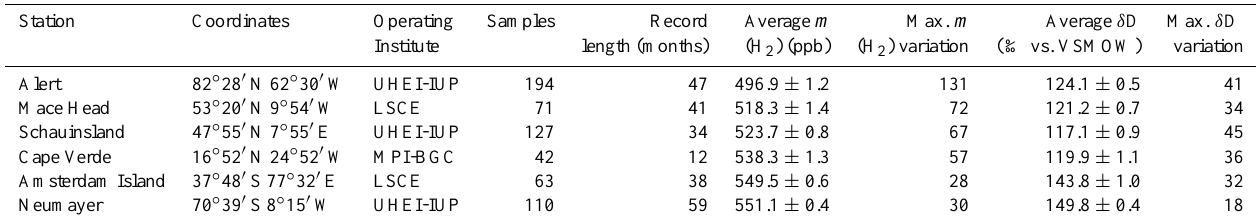
Table 2. The locations and operating institutes of the six EUROHYDROS flask sampling stations discussed here, and the length, average values and maximum variations of their m(H 2 ) and δ D sample